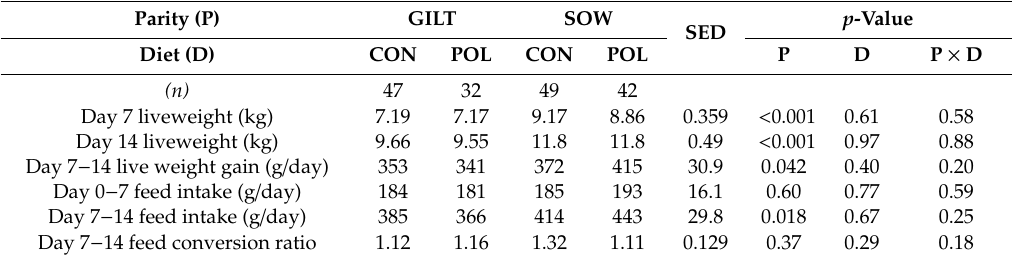
Table 2. The e ff ect of parity (gilt vs. sow) and diet (control, CON vs. 0.5% dietary Polygain, POL) on the post-weaning performance of dam progeny. Parity (P) GILT